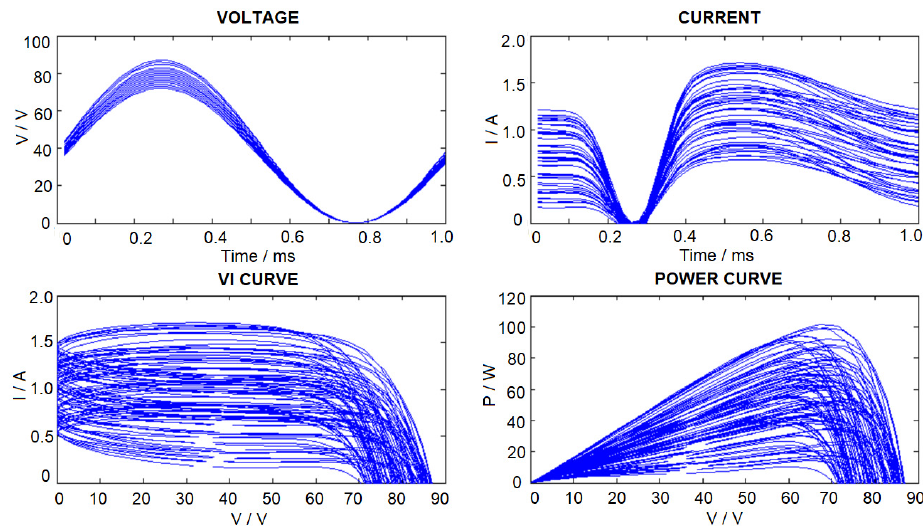
Figure 7. Samples of data curves of the training dataset. Table 1. Estimation ranges of the model parameters. (Solar panel reference model: Sungen SG-NH80-GG 80 W, a-Si type).